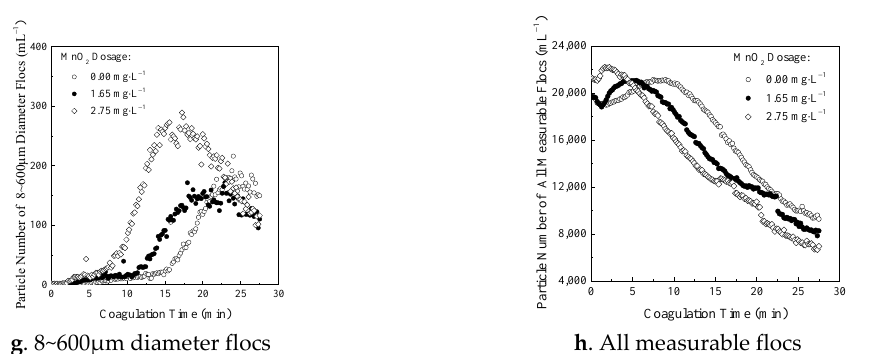
Figure 3. Change in the number of flocs with coagulation time. ( a )–( g ) The number of flocs with a diameter of 2~3 μm, 3~4 μm, 4~5 μm, 5~6 μm, 6~7 μm, 7~8 μm, and 8~600 μm; ( h ) the number of all measurable flocs.